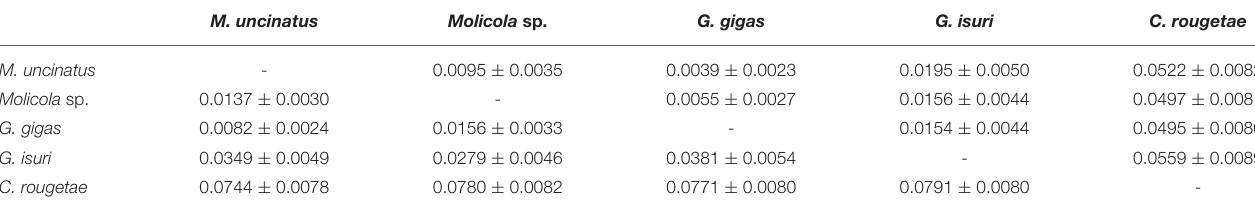
TABLE 2 | K2P genetic distance ± standard error (SE) between species of family Gymnorhynchidae.